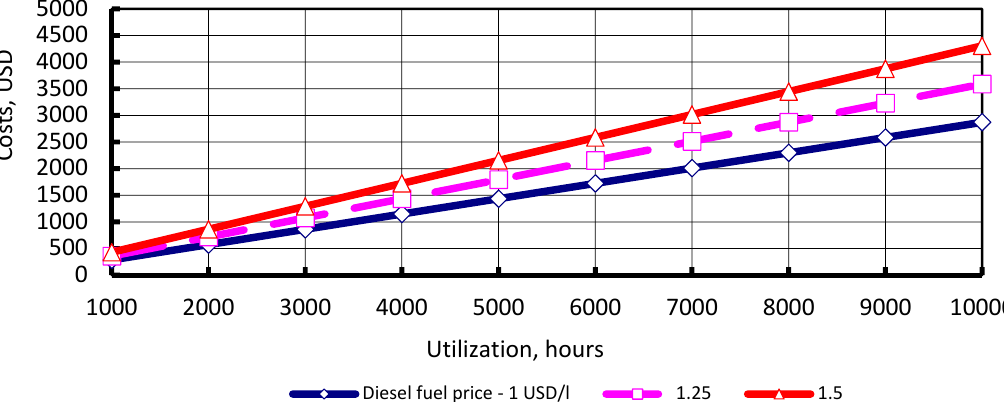
Figure 10. Fuel cost reduction from thermoelectric generators (TEG), USD/kW. Source: developed by authors.